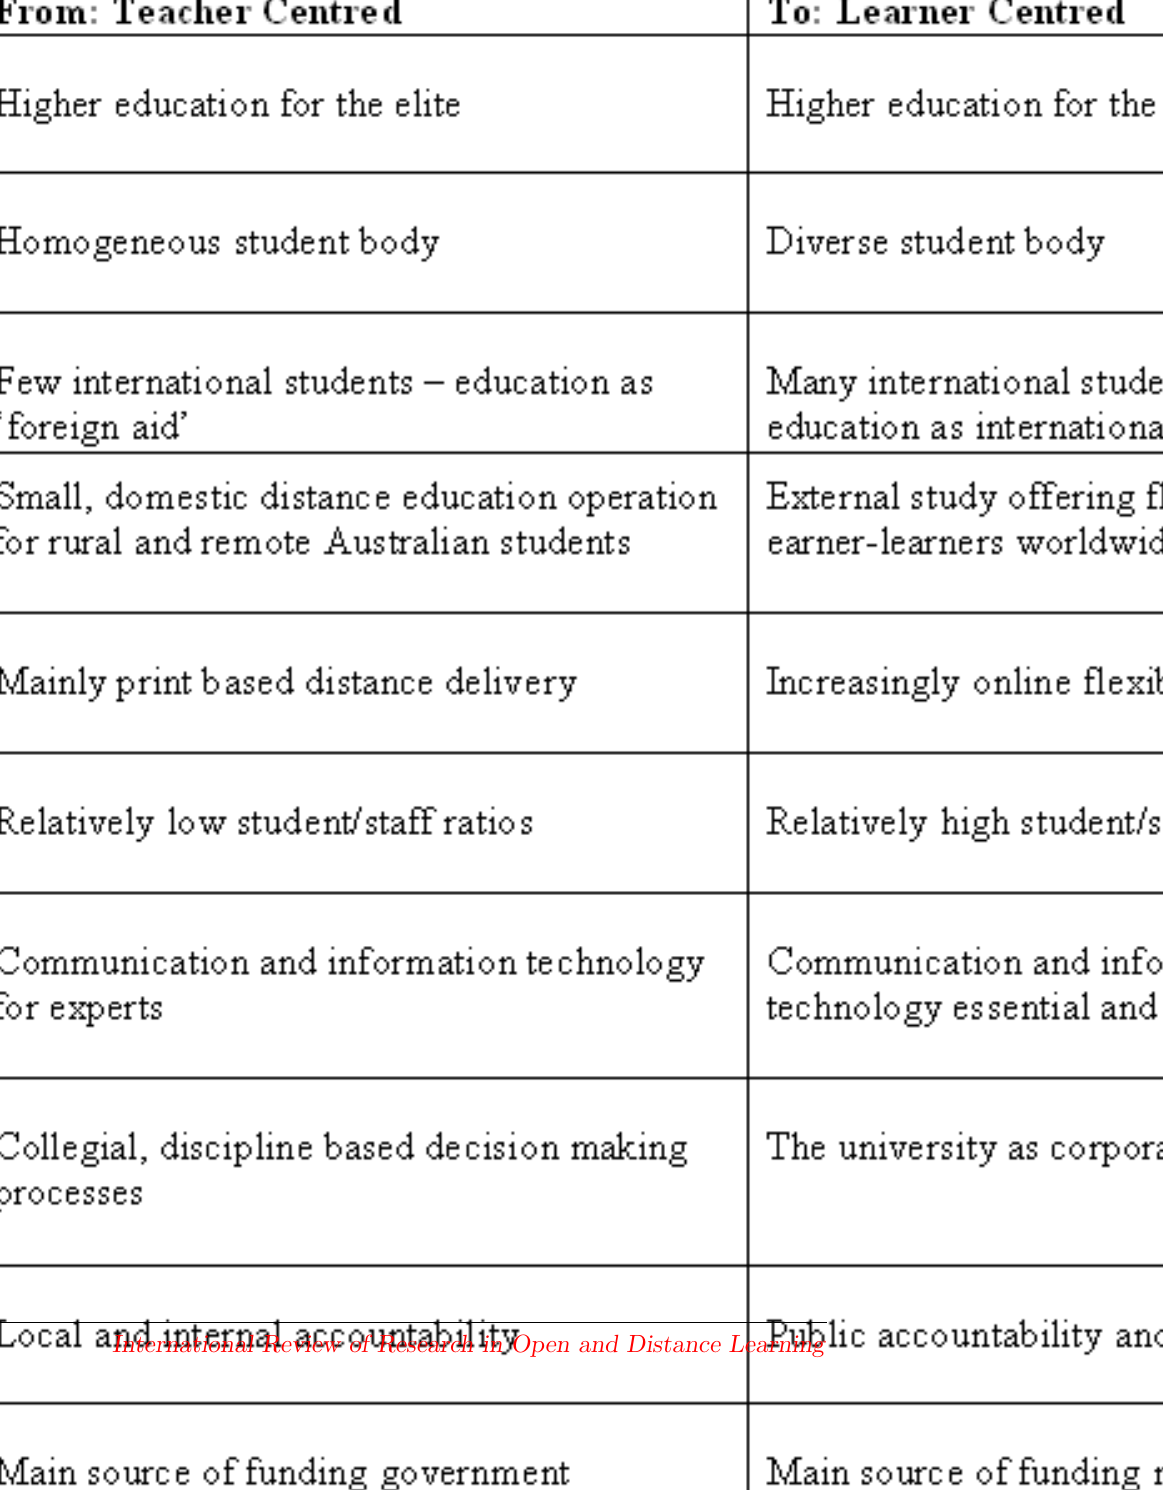
International Review of Research in Open and Distance